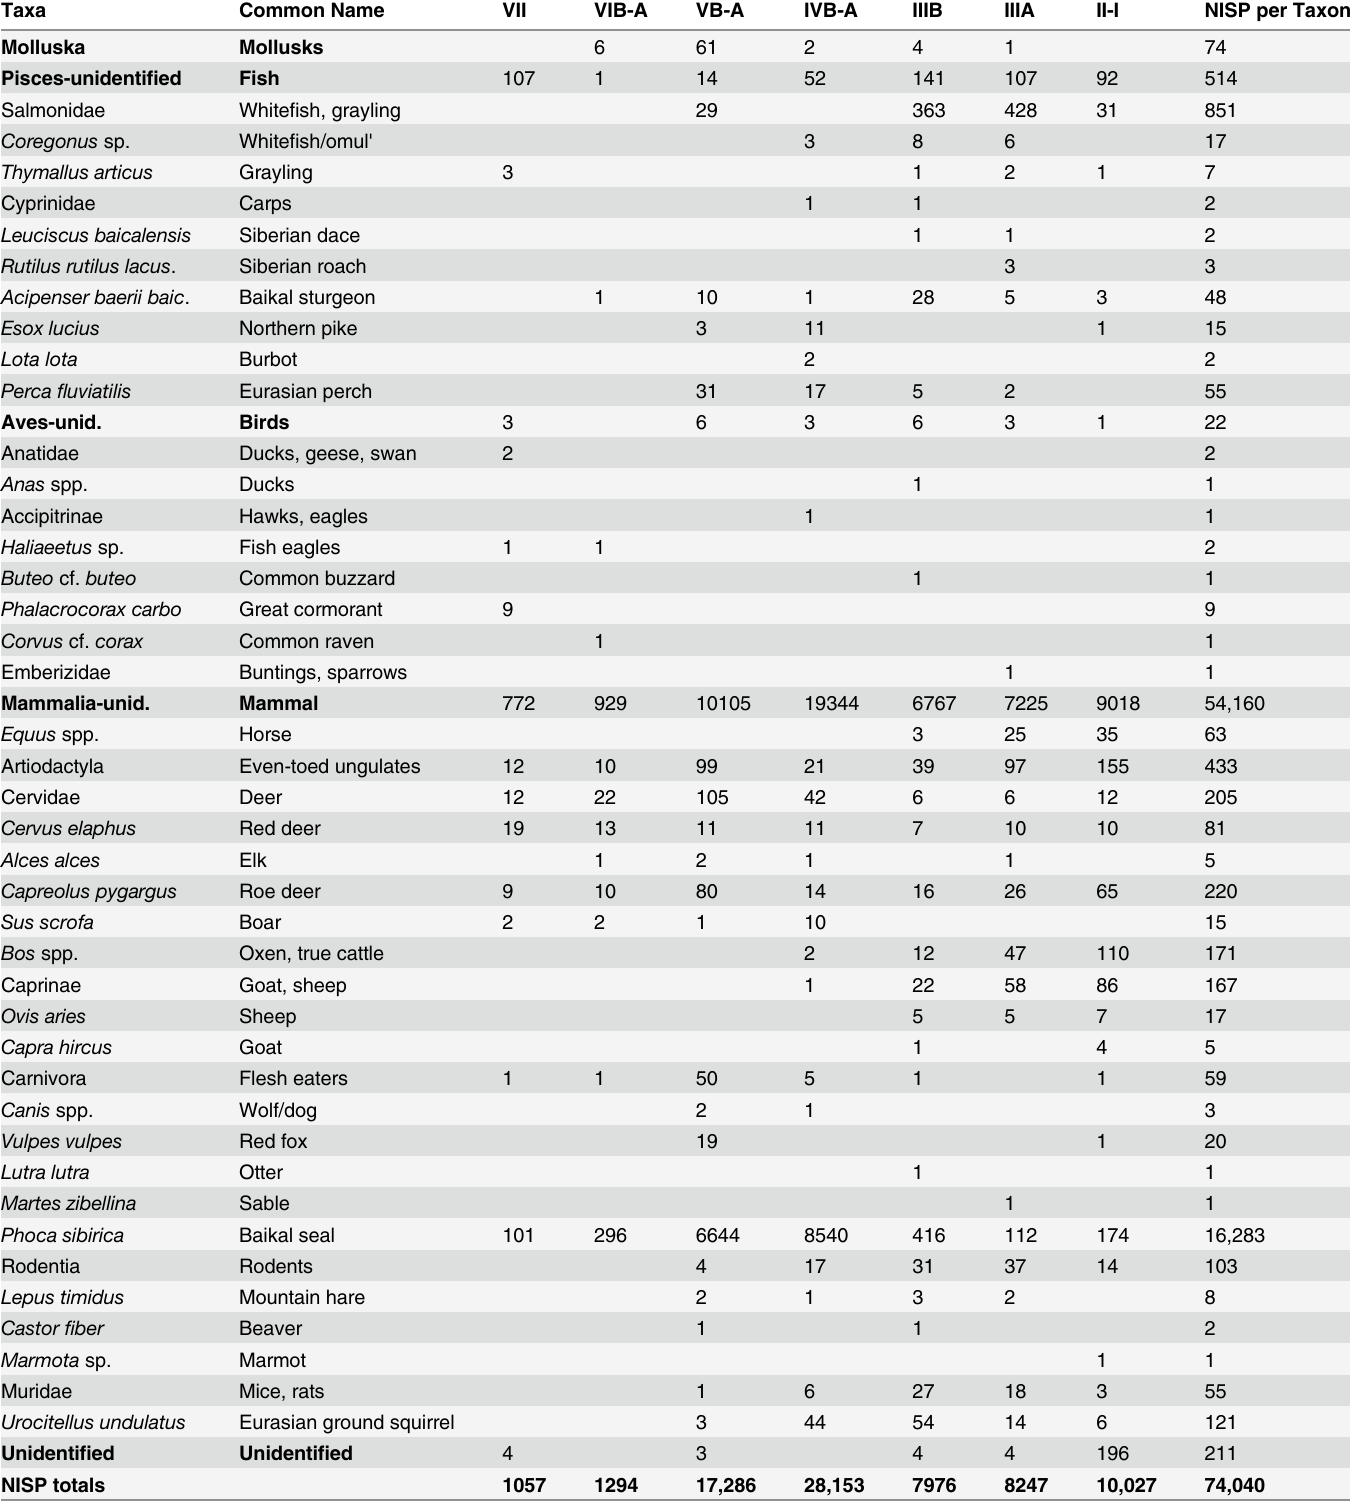
Table 2. Faunal remains from Sagan-Zaba II trenches